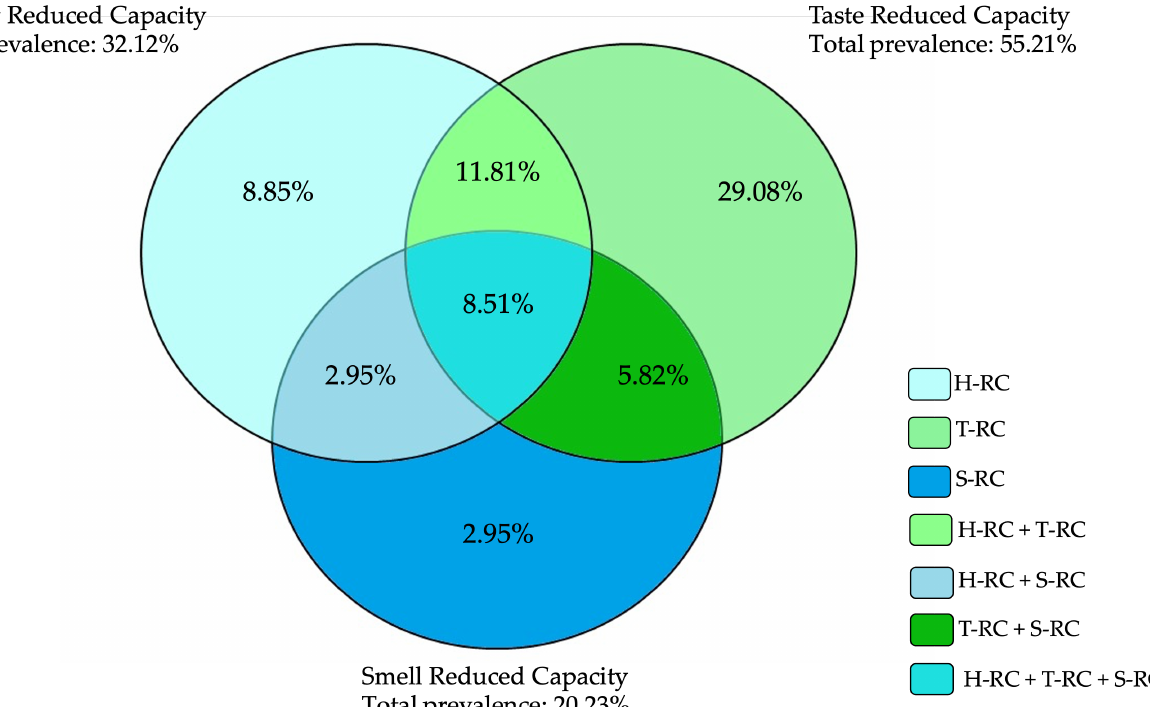
Figure 1. Venn diagram of the prevalence of reduced sensory capacities (RSCs). The graph shows the distribution of RSCs in our populations, highlighting the prevalence of single and multiple RSCs. H-RC, T-RC, S-RC = reduced capacity in hearing, taste, and smell,